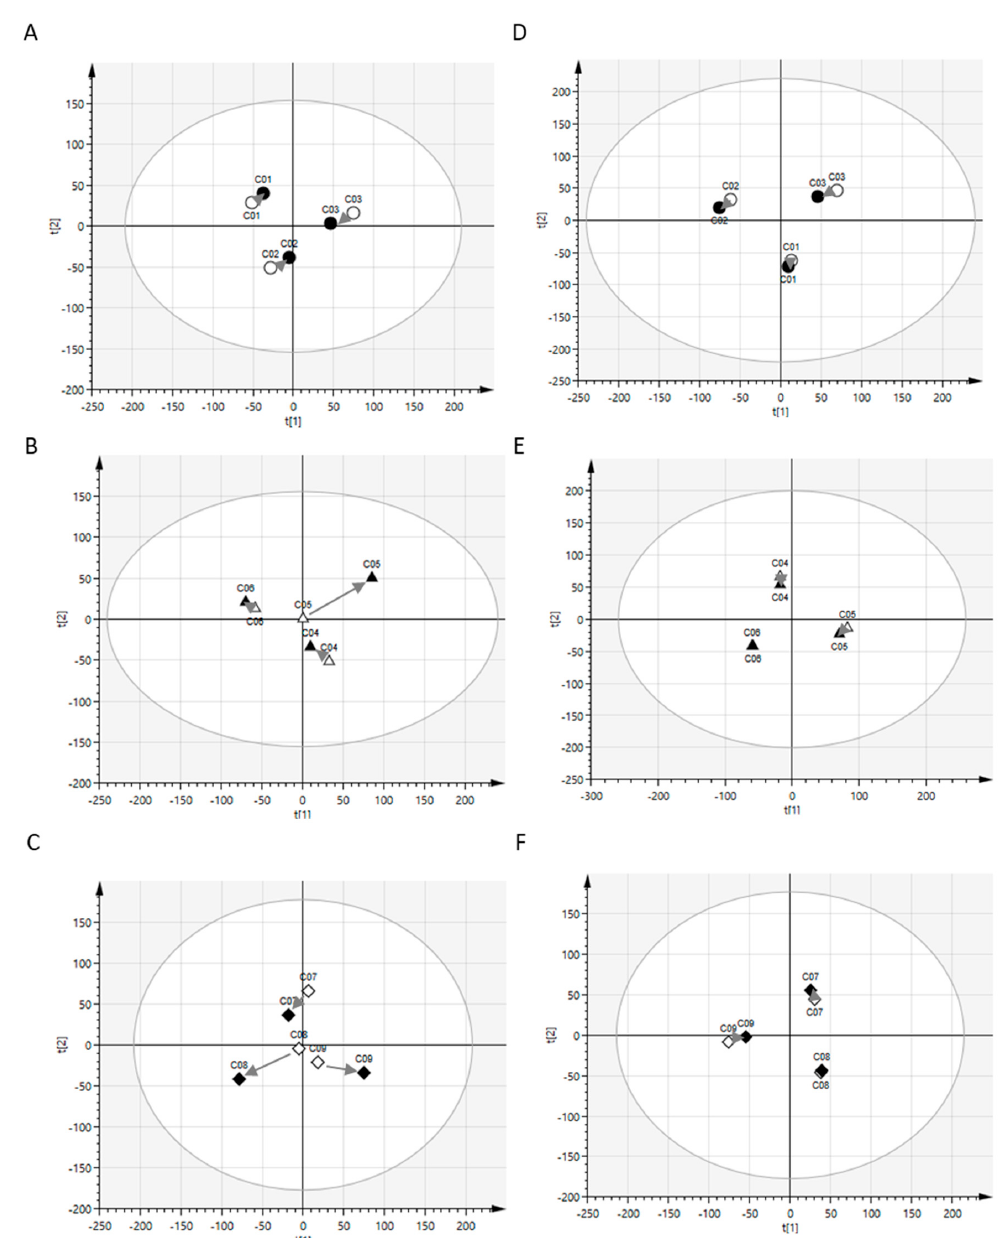
Figure 2. PCA model of lipids. Data obtained from the CSF ( A – C ) and plasma ( E – F ) of preprandial (white) and postprandial (black) subjects were analyzed. The prandial periods were 1.5 h (circle), 3 h (triangle), and 6 h (diamond). The grey arrows indicate the change in levels of different metabolites in preprandial and postprandial samples of individual subjects. The circle around the samples indicates the tolerance ellipse determined by Hotelling’s T 2 with a two-dimensional score plot (95% tolerance was set for all the data analyses in this study). Data points outside the ellipse represent the outliers (none in this study).